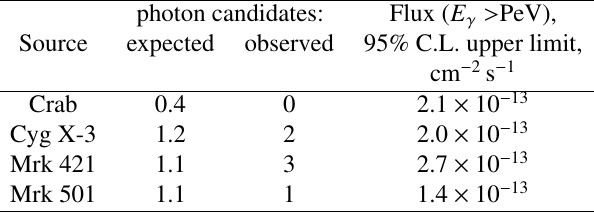
Figure 1. Selection of photon candidate n µ plane. Blue dots events on the N e − represent all Carpet-2 events which passed the quality cuts. Photon candidates (muon-poor events) are in the shaded region. See the text for more details.